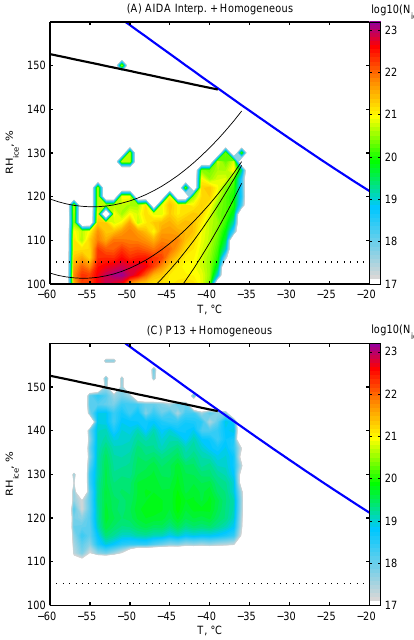
Figure 8. Accumulated ice crystal concentrations (color scale in to- tal crystals per model domain) as a function of temperature (1 ◦ C bins) and RH ice (2% bins). Heterogeneous nucleation simulated by AIDA parameterization (i.e., Fig. 4a) and P13 parameterization (i.e., Fig. 4c) was combined with homogeneous nucleation of cloud